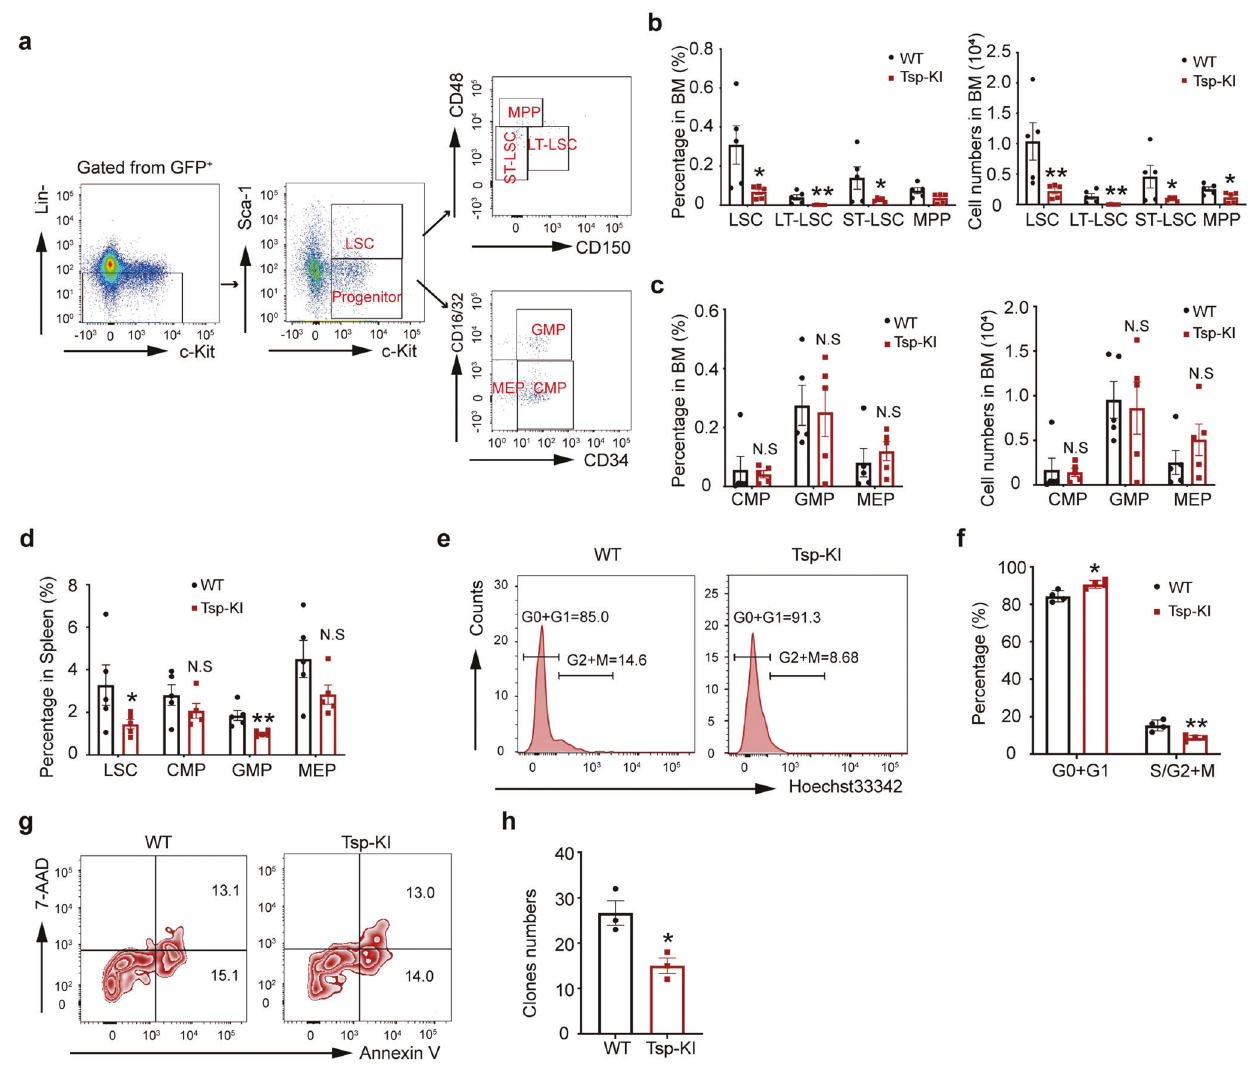
Fig. 4 Tspan32 overexpression represses CML-LSCs proliferation and impedes its function. a On day 14 post BMT, recipient mice were analyzed to determine the percentage and number of LSCs and progenitors ( n = 5 per group) ( b ) LT-LSCs, ST-LSCs and MPP percentage and number within LSCs in BM were analyzed ( n = 5 per group). c CMP, GMP and MEP percentage and number within the progenitors in BM were analyzed ( n = 5 per group). d The percentage of LSCs and progenitors in the spleen were analyzed ( n = 5 per group). e , f The cell cycle analysis for BCR-ABL expressing LSCs from BM of recipient mice via Hoechst3342 staining ( n = 4 per group). g BCR-ABL expressing LSC apoptosis within BM of recipient mice. h Colony formation assay. Sorted BCR-ABL-expressing LSCs from recipient mice BM were seeded into 6 well plates containing 2 mL M3234 medium, the total number of colonies were counted after 7 days, representative data displayed. Error bars denote mean ± SEM, N.S. no signi fi cance, * P < 0.05, ** P < 0.01 ( T